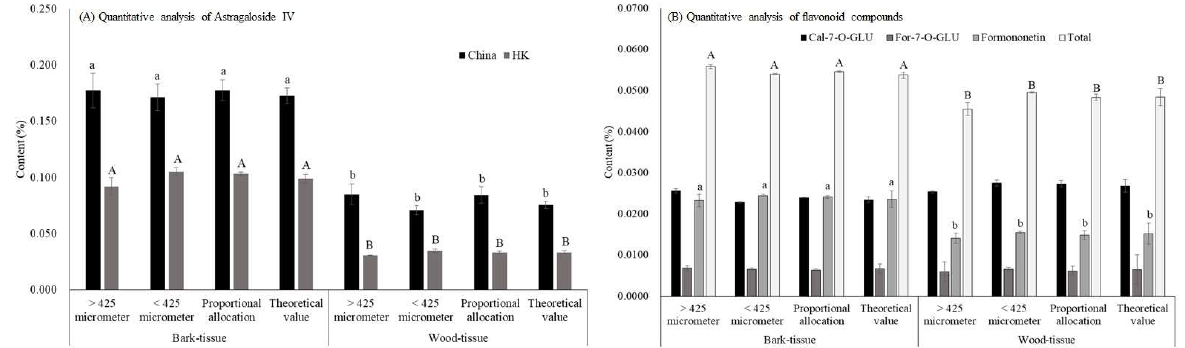
Figure 4. Effects of bark- and wood-tissue with diverse powder particle size on the content of Astra- galoside IV ( A ) and flavonoids ( B ) in Astragali radix . Data are expressed as mean ± SD from three separate experiments; means not sharing an alphabetic letter (left panel: lowercase for China and uppercase for HK; right panel: lowercase for formononetin and uppercase for total flavonoids)